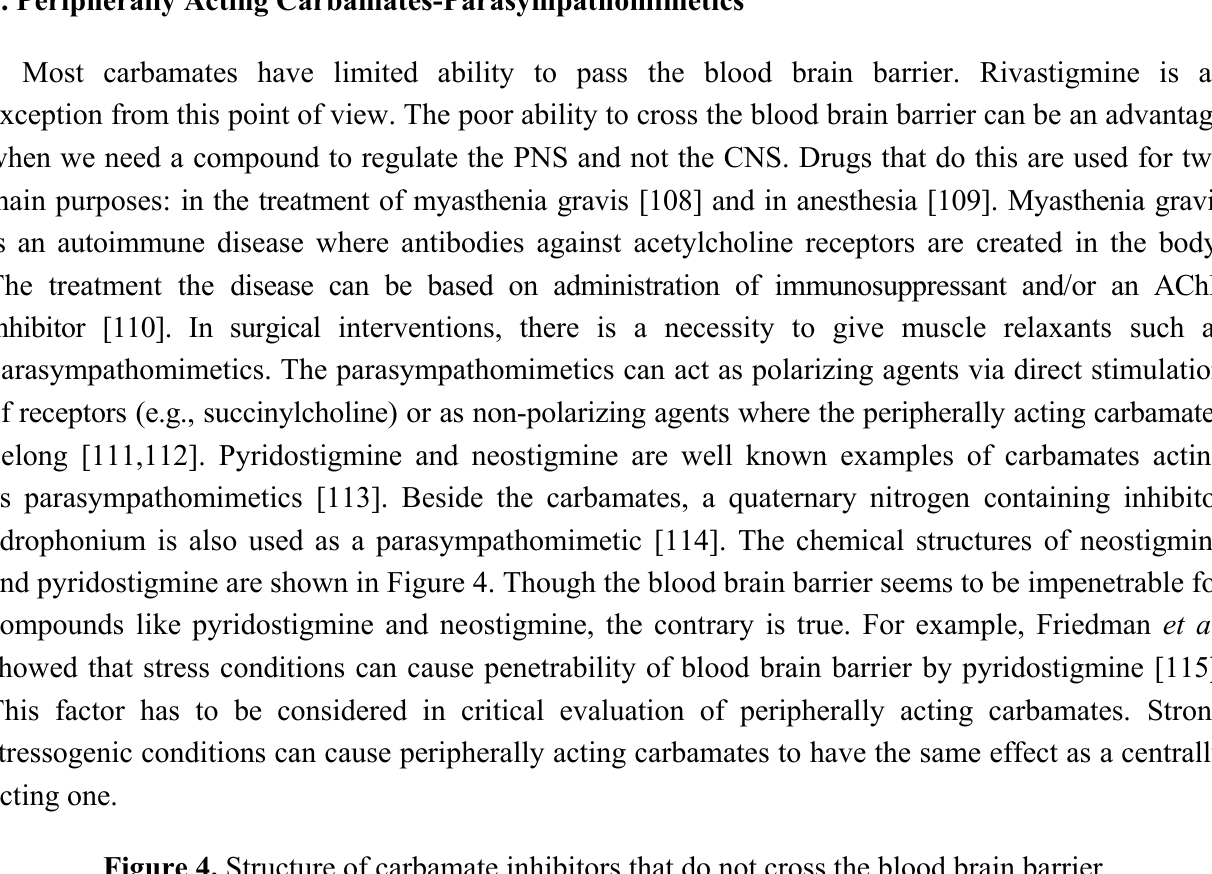
Figure 4. Structure of carbamate inhibitors that do not cross the blood brain